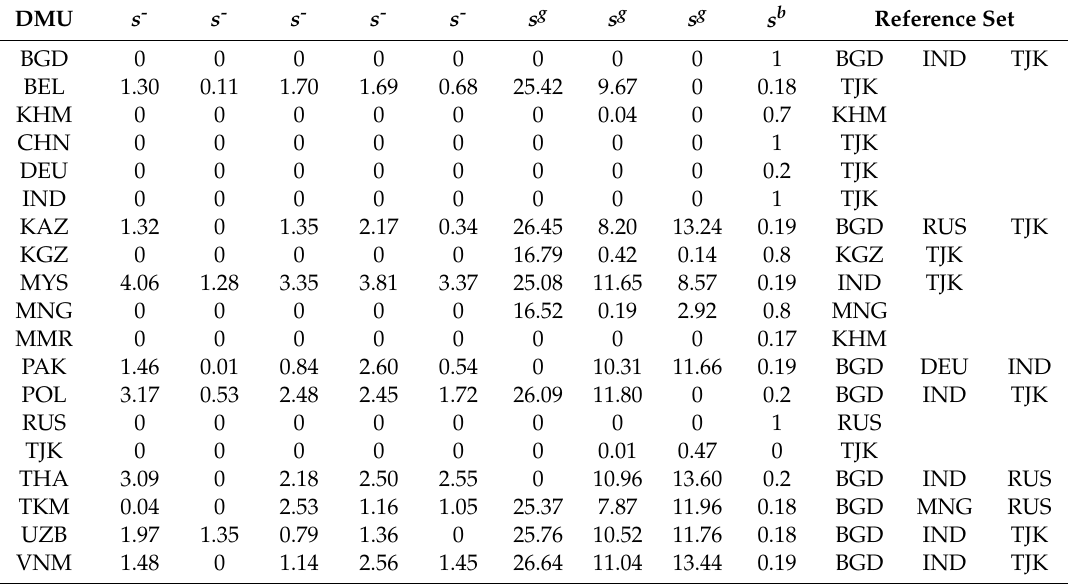
Table 8. Decomposition of the projected ine ffi ciency and additive